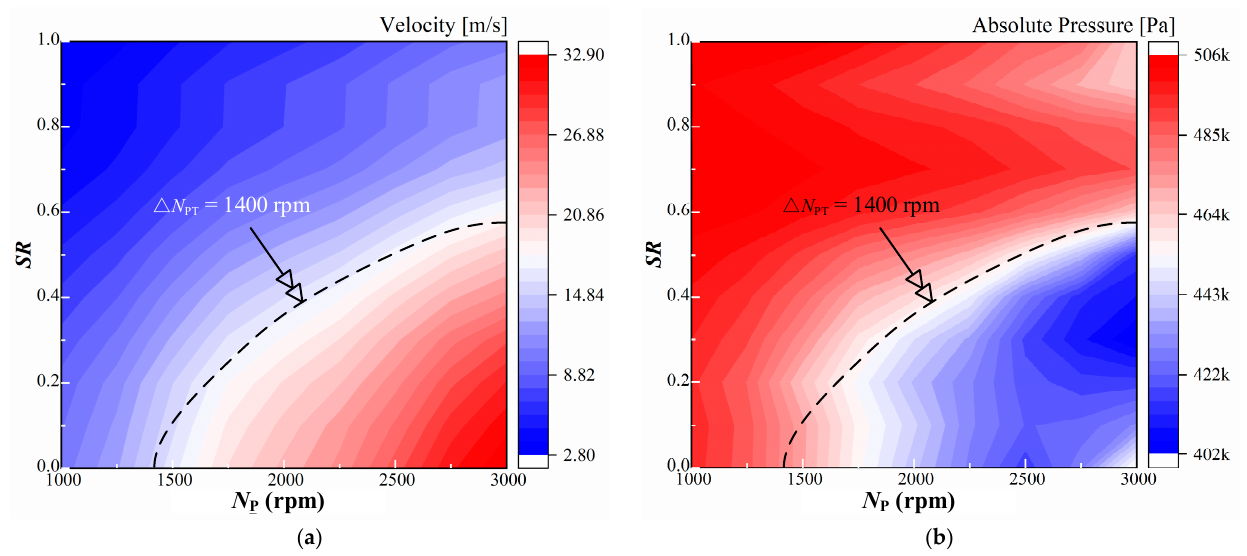
Figure 17. The average velocity and average absolute pressure spectrogram in the stator domain under various N P and SR . ( a ) The average velocity spectrogram. ( b ) The average absolute pressure spectrogram.